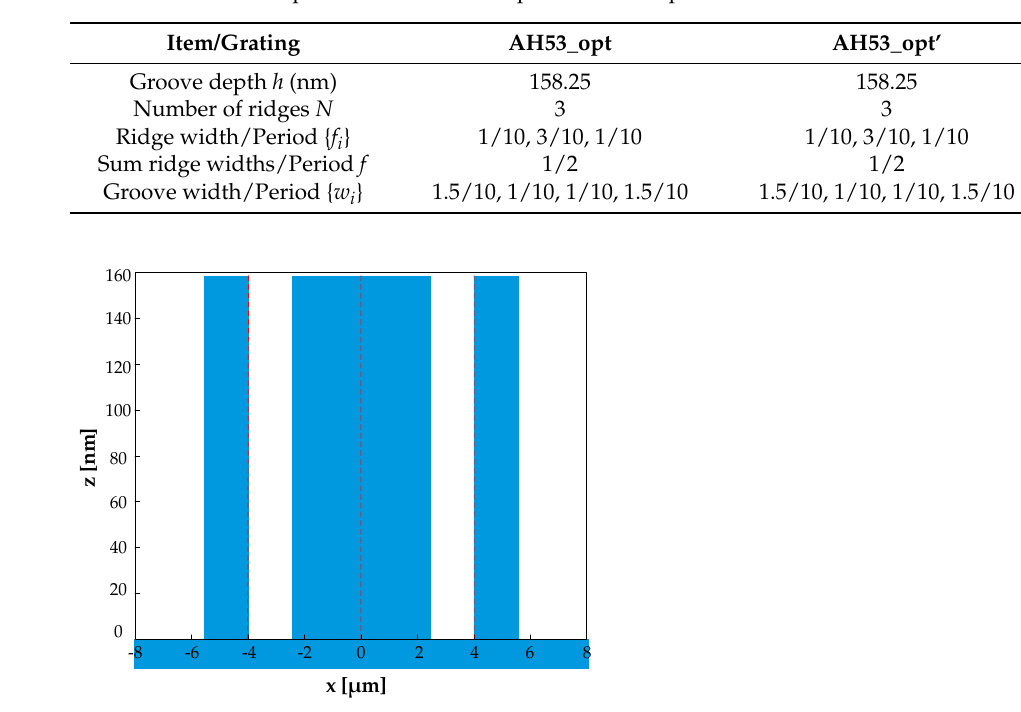
Figure 14. The structure of AH53_opt and AH53_opt’ in one